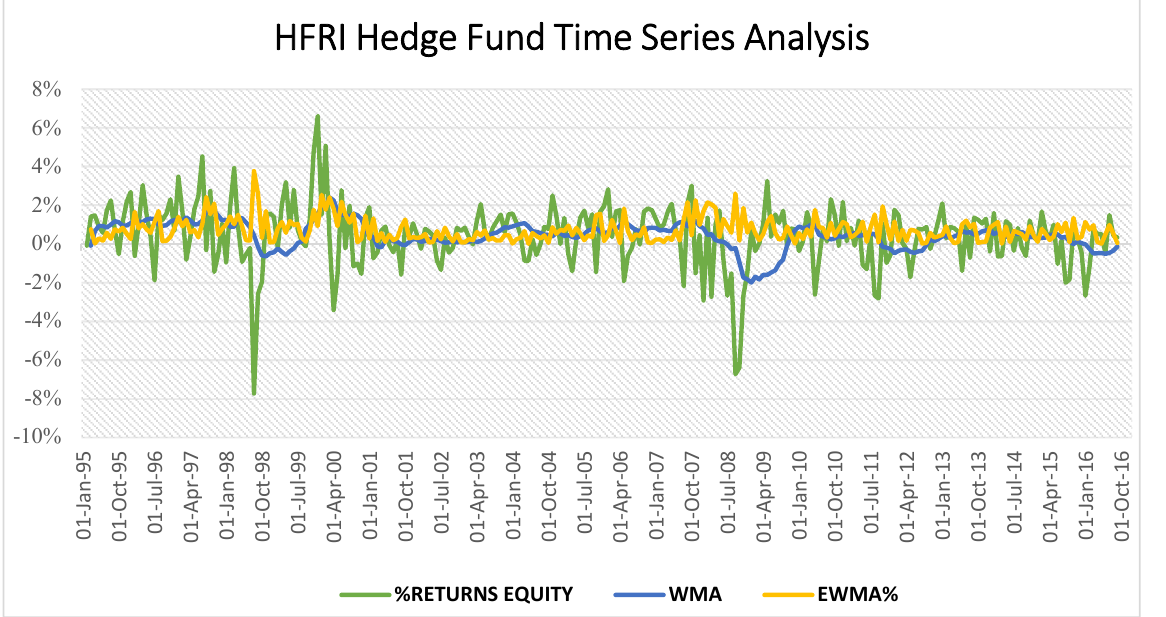
Figure 9. HFRI monthly time series analysis, hedge fund. Source: authors. The DJCS in Figure 10 is also generally stable, since it is a hedge fund and experiences spikes during the stress period as it is based on liquid securities. This means that any change in the financial markets is reflected in the returns. It is noted that the WMA is relatively stable over time.